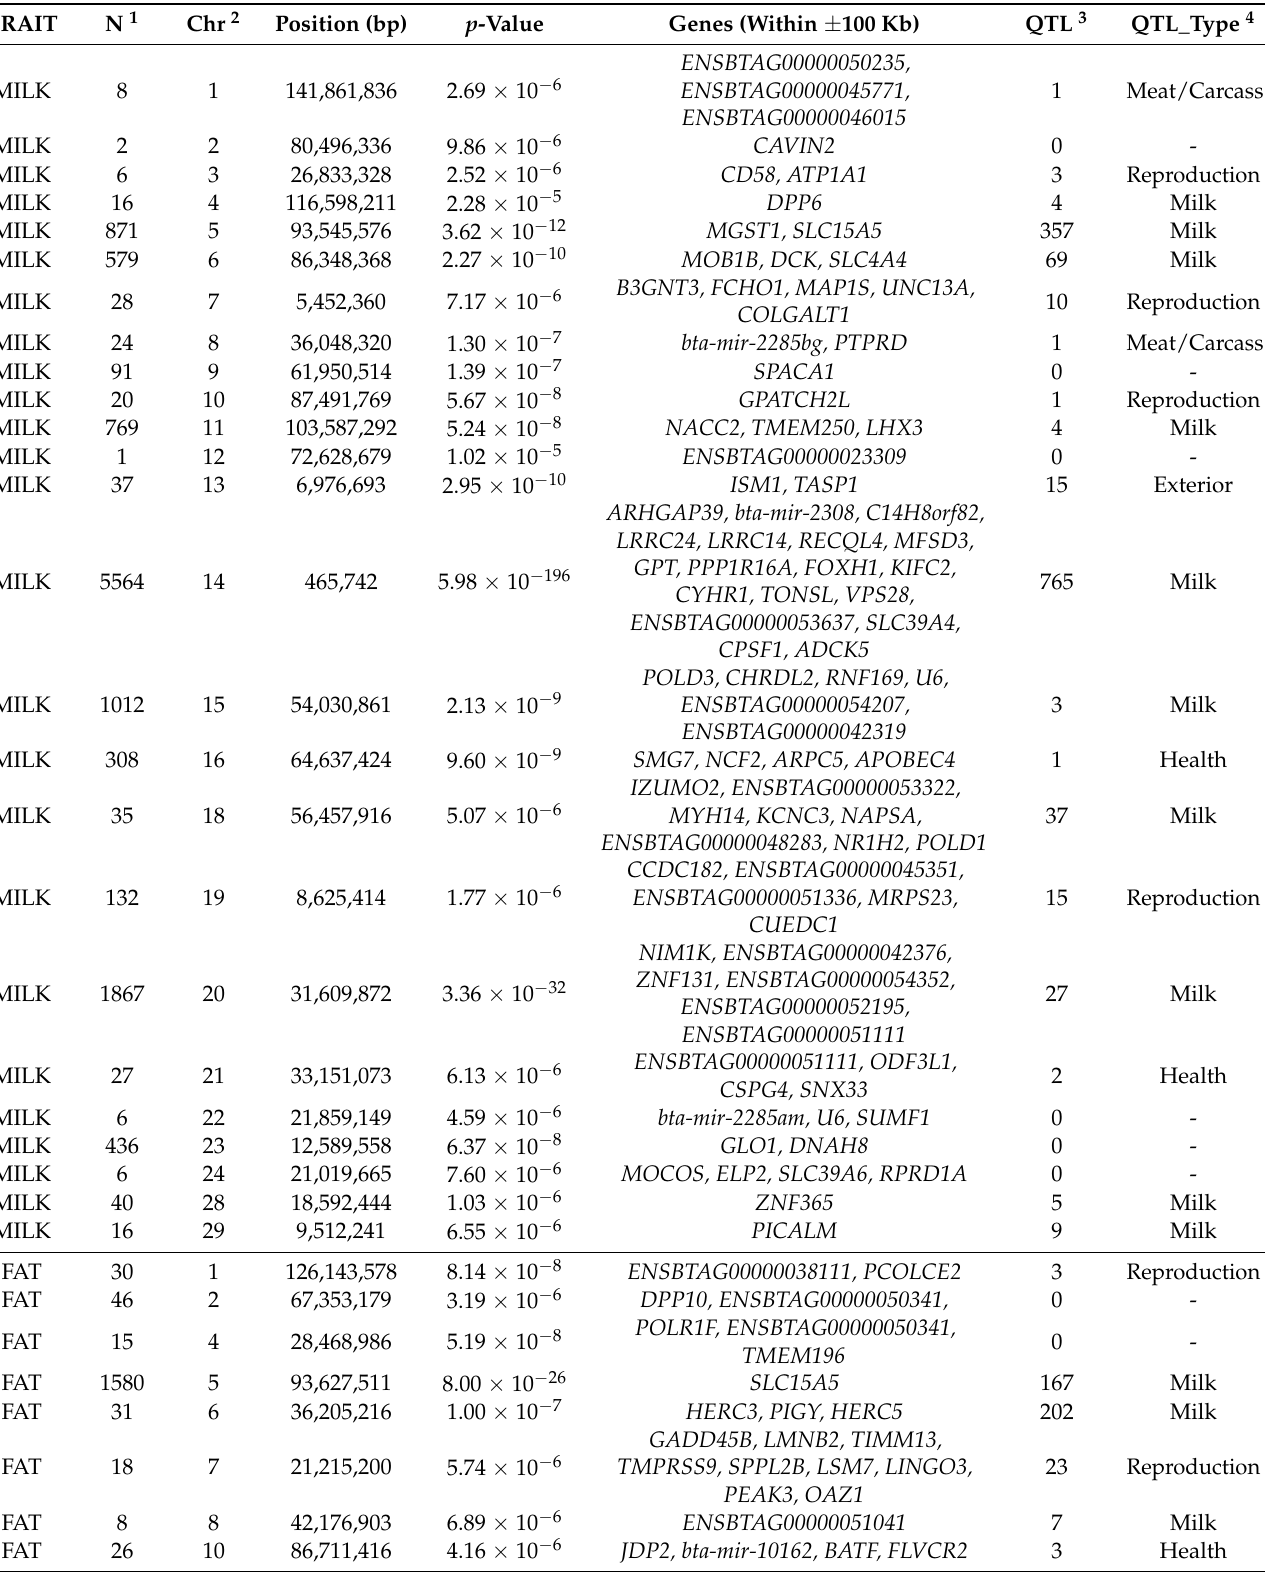
Table 2. Description of SNPs, most significant genes, and number of QTLs significantly associated with milk yield (MILK), fat yield (FAT), and fat percentage (FAT%) in North American Holstein